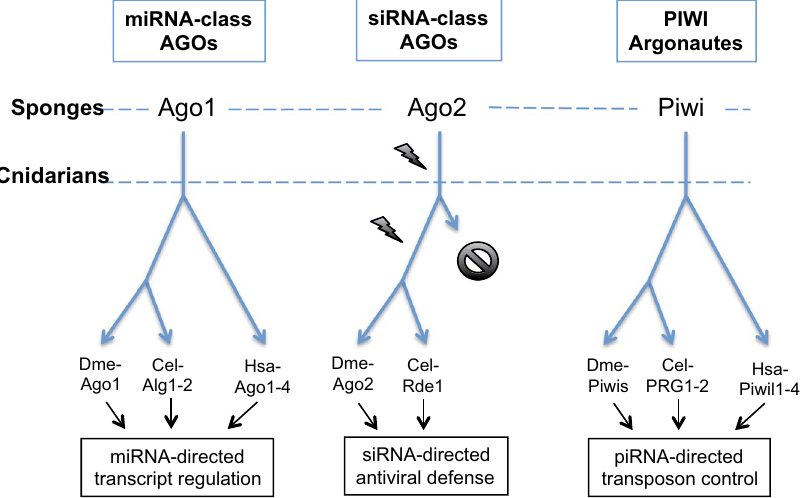
Figure 6. The evolution of the metazoan Argonaute superfamily. The miRNA-class AGO, siRNA-class AGO and PIWI Argonaute lineages are conserved between sponges, cnidarians, nematodes and insects, while chordates only encode miRNA-class AGOs and PIWIs (the absence of the siRNA-class AGOs in vertebrates is depicted by a black stop sign). Several studies have identified that the miRNA-class AGOs in the fruit fly (Dme-Ago1), C. elegans (Cel-ALG1-2) and humans (Hsa-Ago1-4) can interact with miRNAs and mediate regulation of endogenous transcripts (indicated with black arrows), the siRNA-class AGOs of flies (Dme-Ago2) and C. elegans (Cel-RDE-1) play a crucial role in the defense against viruses (black arrows), and finally, the PIWI Argonautes in flies (Dme-Piwis: Ago3, Piwi and Aubergene), C. elegans (Cel-PRG1-2) and humans (Hsa- Piwil1-4) mediate piRNA-directed control of transposons (also depicted by black arrows). The siRNA-class AGOs are characterized by elevated rates of molecular evolution (depicted by lightning